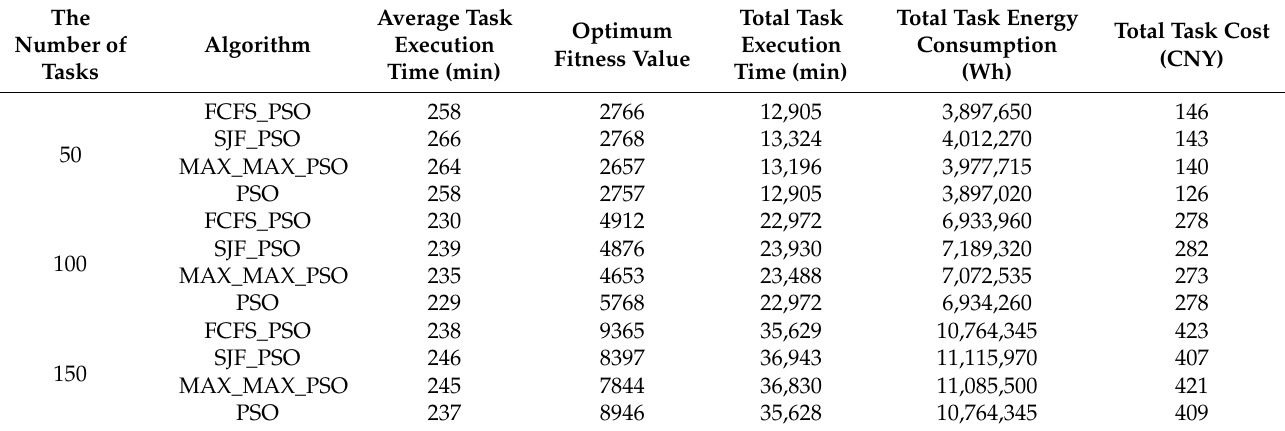
Table 3. Task execution results of different